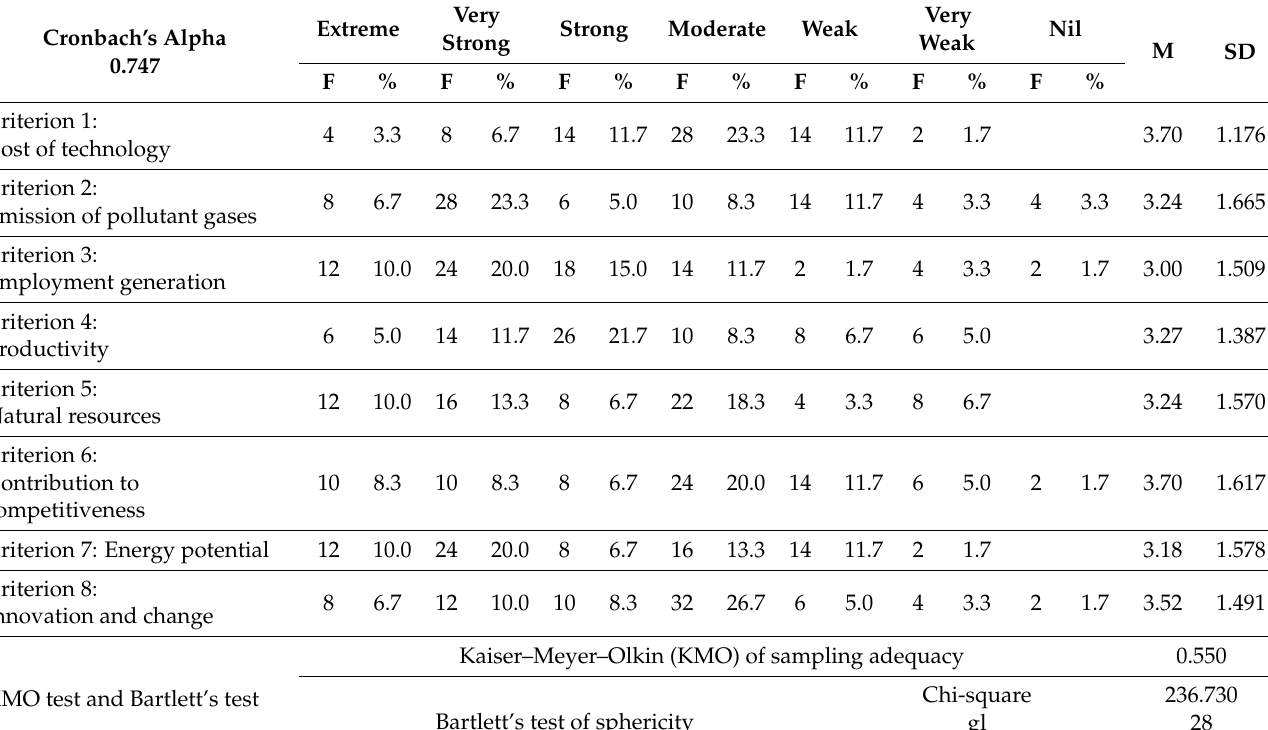
Table 15. Biodiesel attractiveness